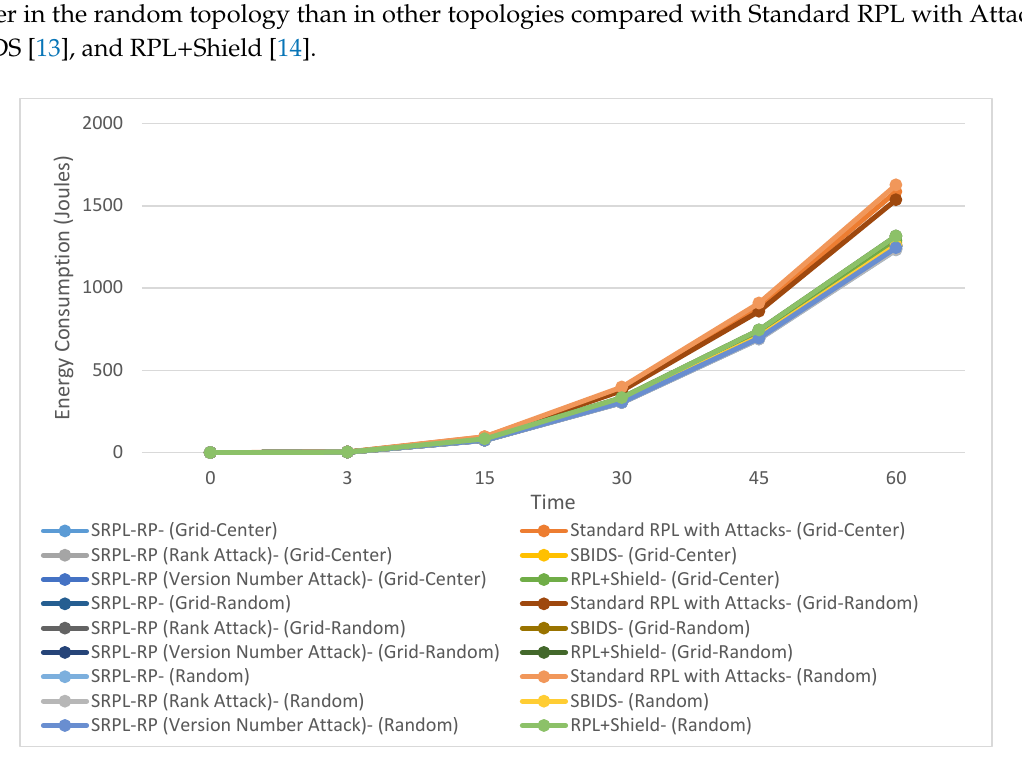
Figure 5. Average Energy Consumption in Three Topologies. Table 9. Average Energy Consumption Comparison in Grid-Center Topology.